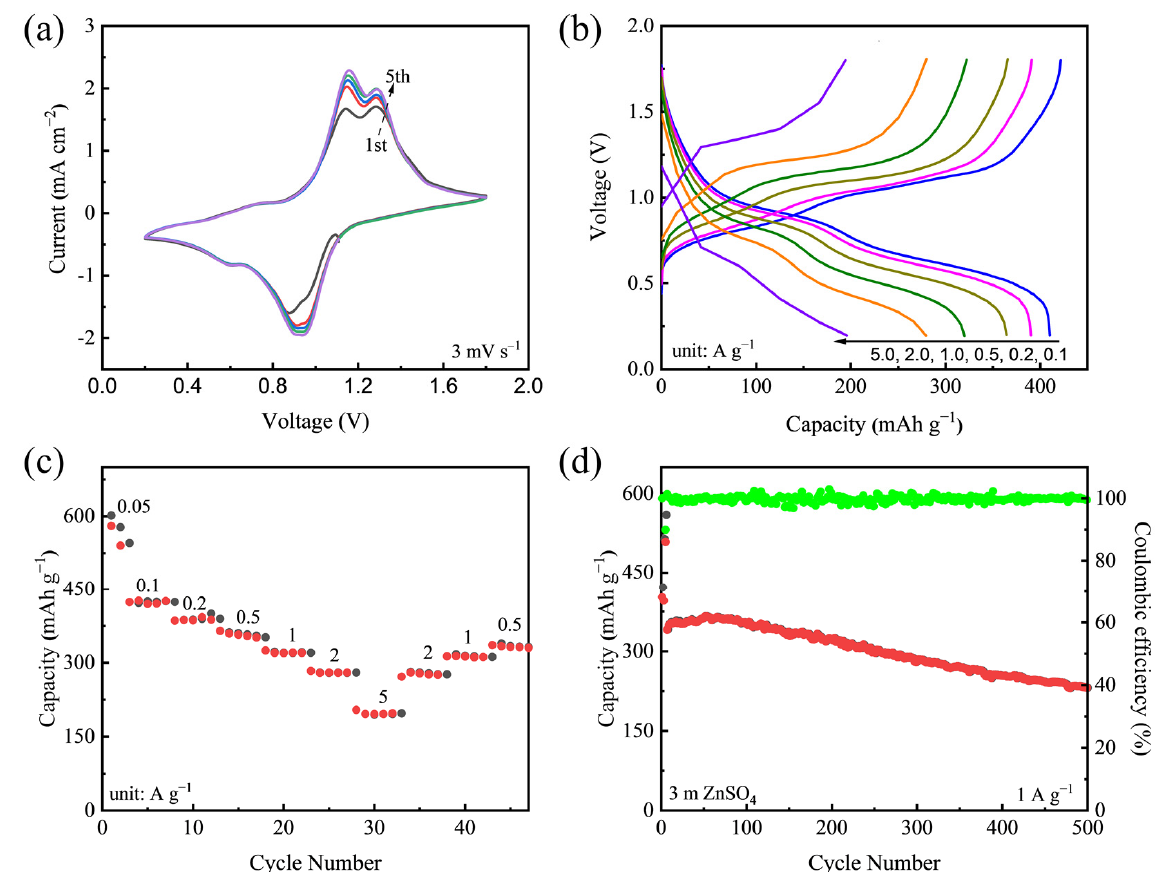
Figure 2. ( a ) CV curves of the V 2 O 5 · n H 2 O nanorod electrode in a 3 m ZnSO 4 aqueous electrolyte using Zn foil as a counter electrode at a scan rate of 3 mV s − 1 . ( b ) Galvanostatic discharge–charge (GCD) voltage profiles of the V 2 O 5 · n H 2 O nanorod electrode at current densities from 0.1 to 5.0 A g − 1 . ( c ) Specific capacities of the V 2 O 5 · n H 2 O nanorod electrode at various current densities for 5 cycles. ( d ) Long-term cycling performance and corresponding Coulombic efficiencies of the V 2 O 5 · n H 2 O nanorod electrode at 1.0 A g − 1 .